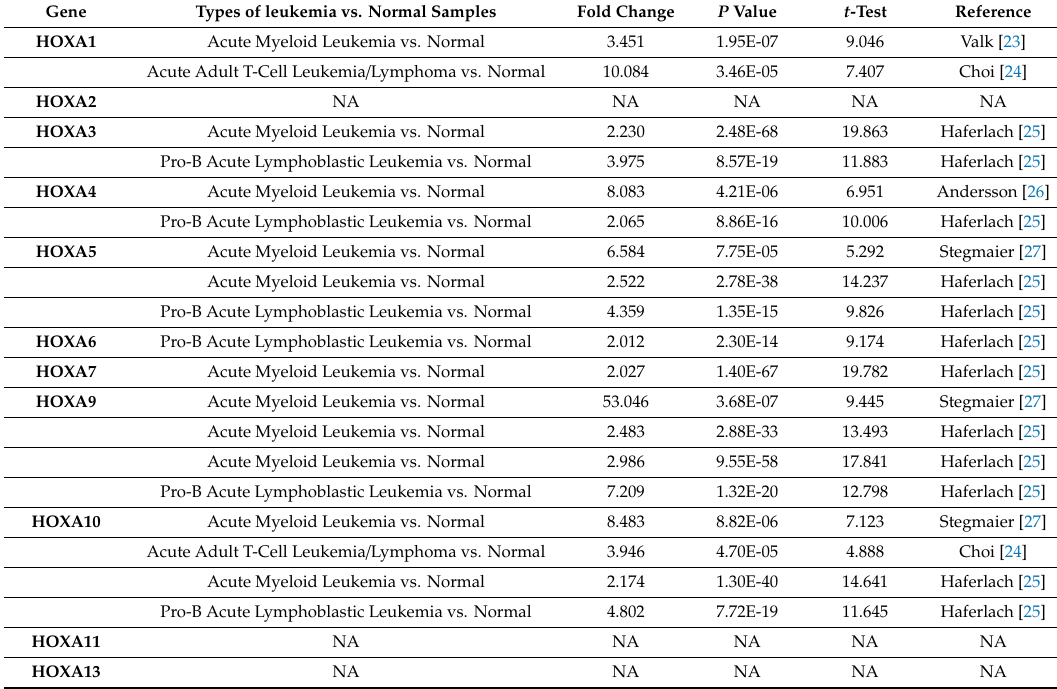
Abbreviations: NA, not available.